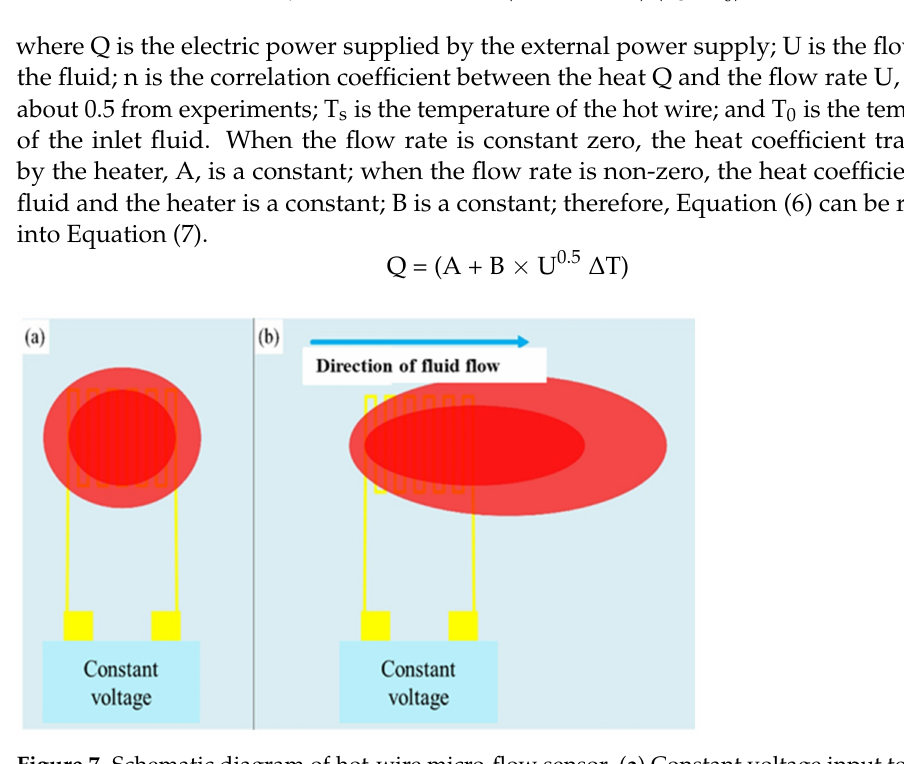
Figure 7. Schematic diagram of hot-wire micro-flow sensor. ( a ) Constant voltage input to generate heat source (red block) to form a stable temperature field; ( b ) Heat is carried away as the fluid flows over the hot wire micro-flow